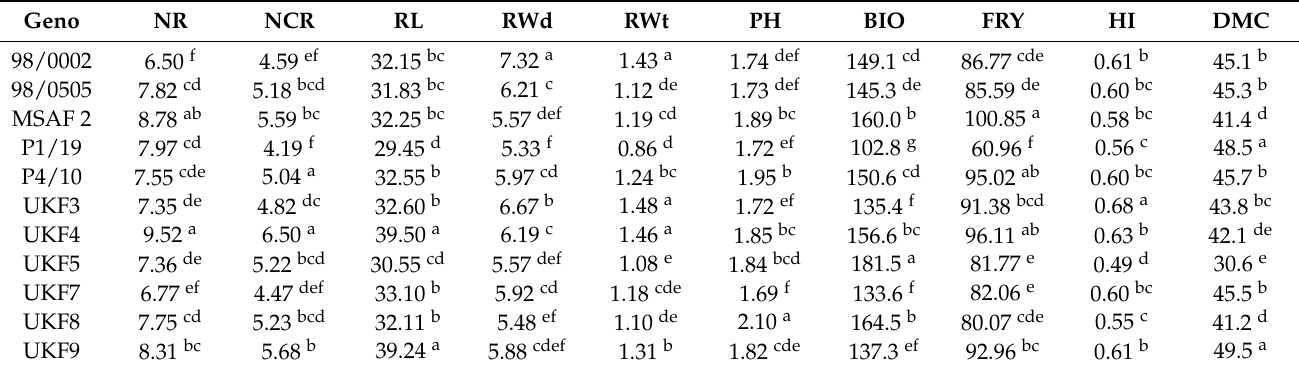
Table 3. Mean separation analysis of 11 quantitative agronomic traits assessed in six environments in South